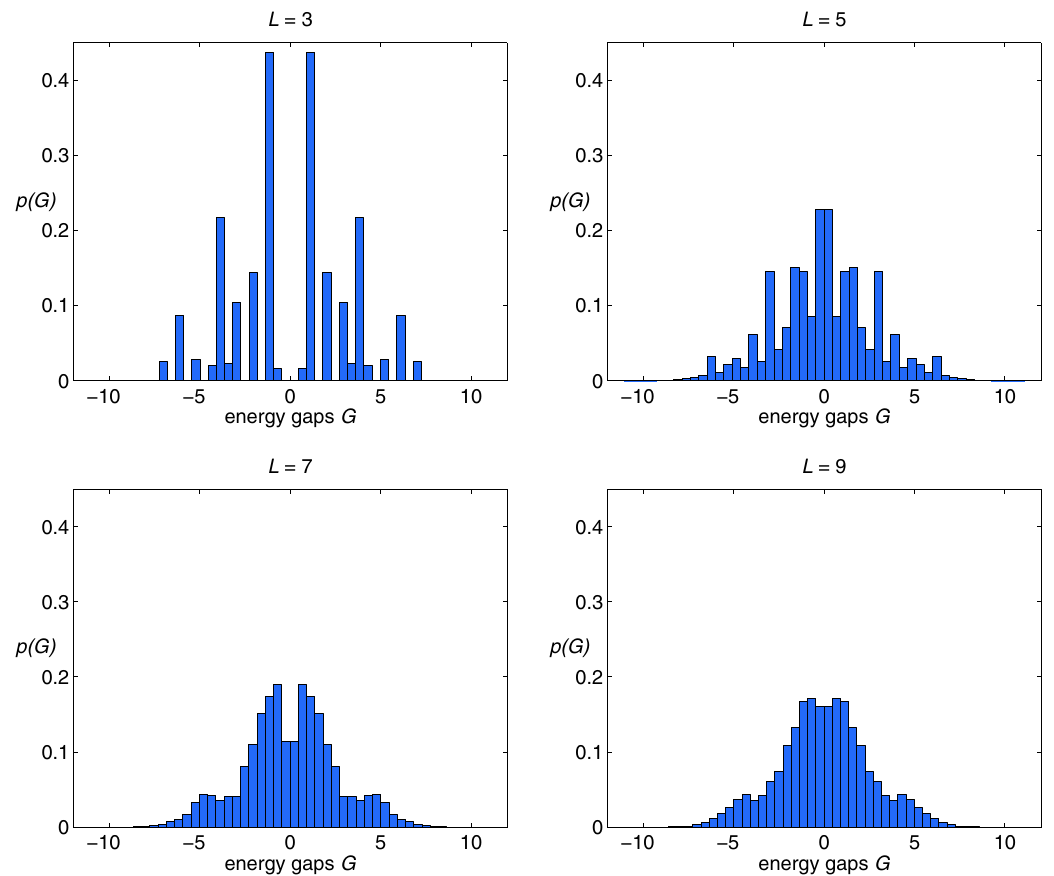
σ x ⊗ ⨂ L 1 ρ 1 ih 1 j ⊗ ⨂ L 1 2 λ and initial state 0 ¼ j λ = 1 λ ¼ 2 λ ¼ 2 x ¼